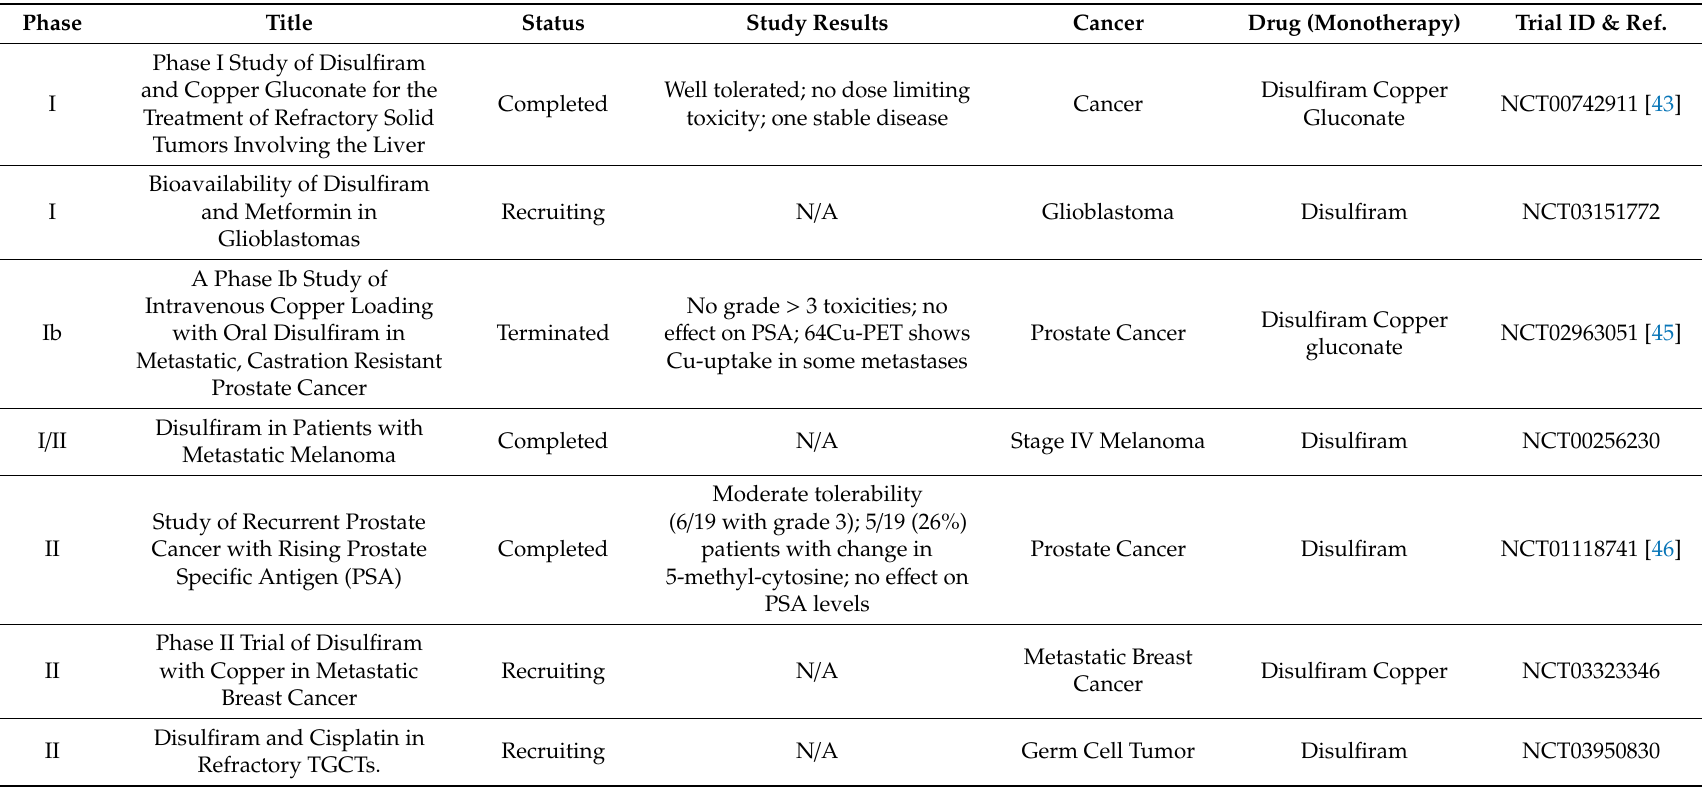
Table 1. Clinical trials using disulfiram as monotherapy in cancer